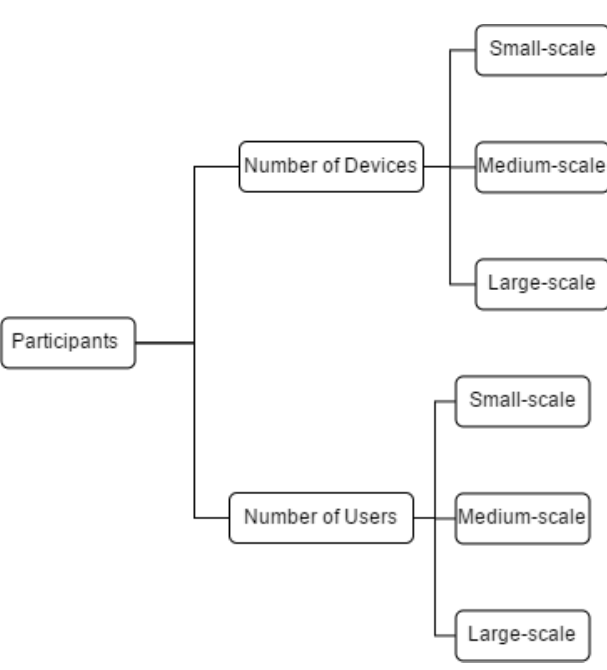
Figure 2. The Participants category of the taxonomy